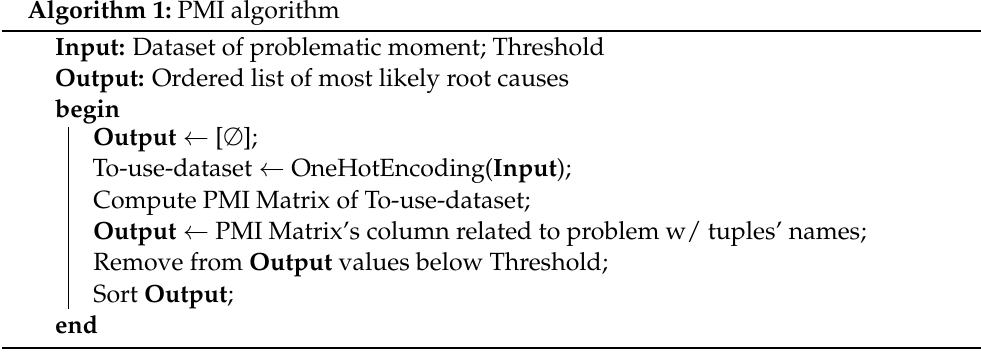
Algorithm 1: PMI